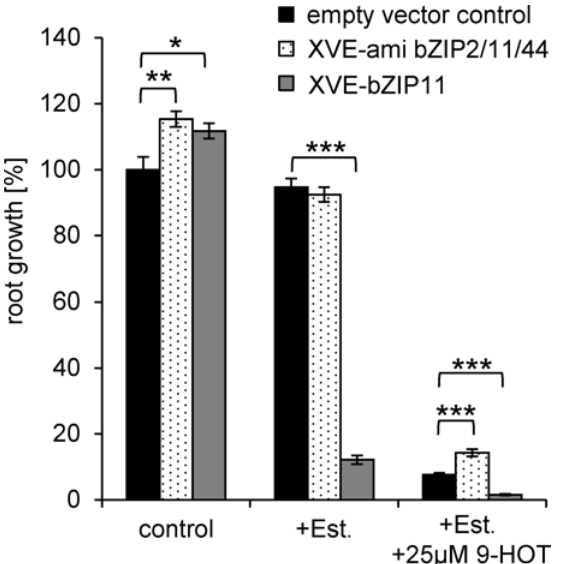
Fig 3. Down-regulation of bZIP11-related TFs enhance root growth upon 9-HOT treatment. Root growth of Est-inducible bZIP11 overexpressing plants (XVE-bZIP11) or artificial micro RNA lines (XVE-amibZIP2/11/ 44) was quantified after application of Est (10 μ M) or Est + 9-HOT (25 μ M). The untreated wt (Col-0) is set to 100%. Given are mean values +SE (n (cid:1) 63). The indicated differences are calculated using the student ’ s t - test: * p (cid:3) 0.05, ** p (cid:3) 0.01, *** p (cid:3)